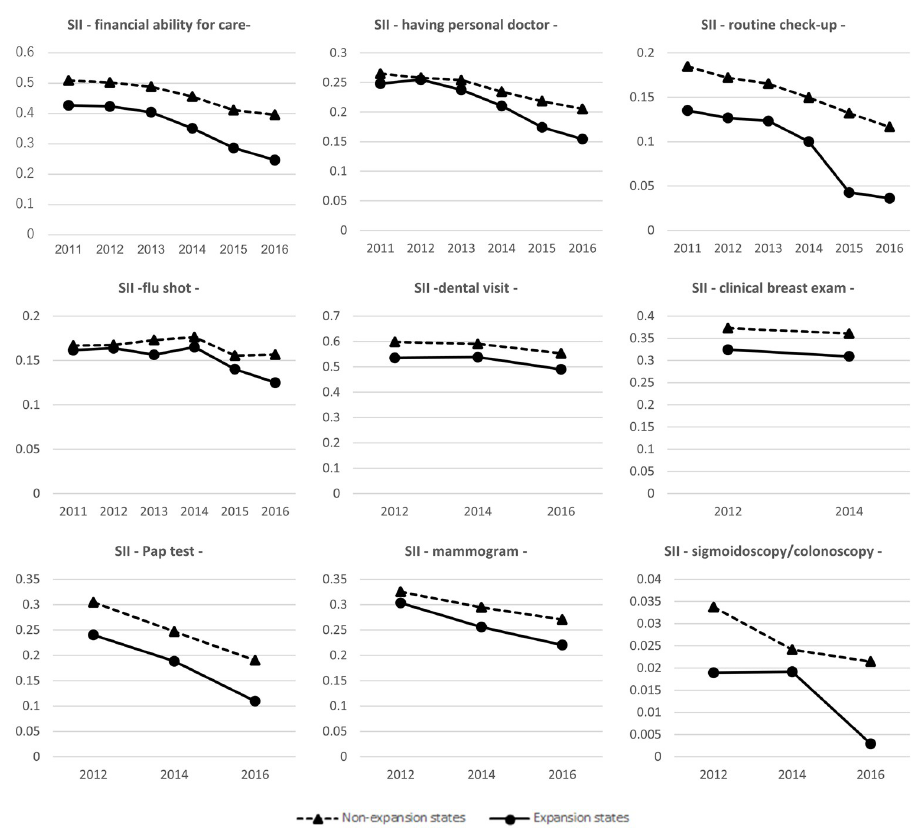
Fig 1. Trends in SII for expansion and non-expansion